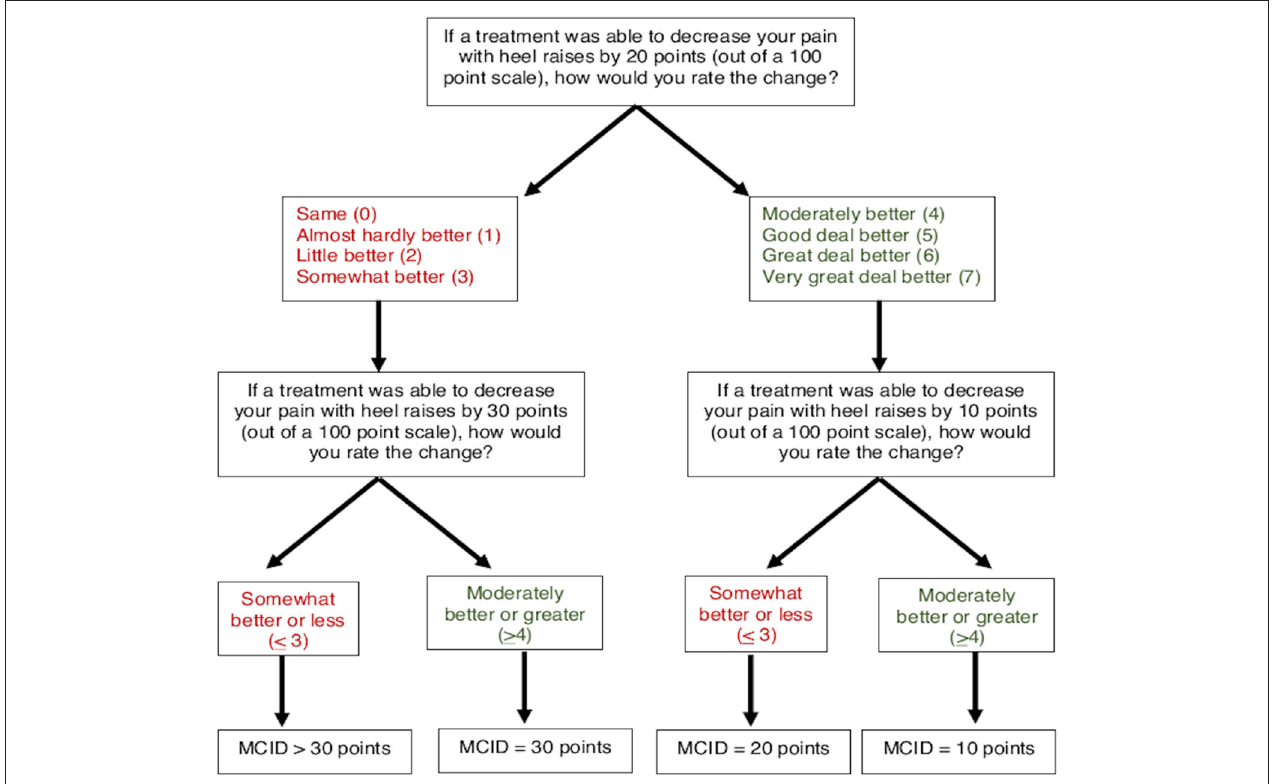
FIGURE 4 | Flow chart for determining patient-driven MCID for pain with heel